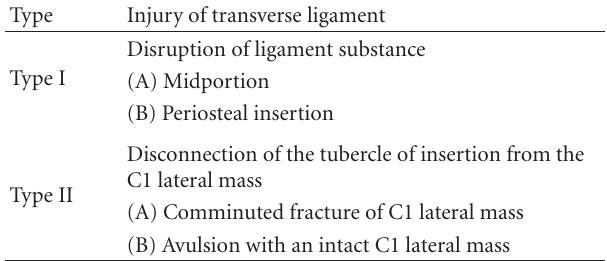
Table 2: Classification of transverse ligament injuries byDickman et al.